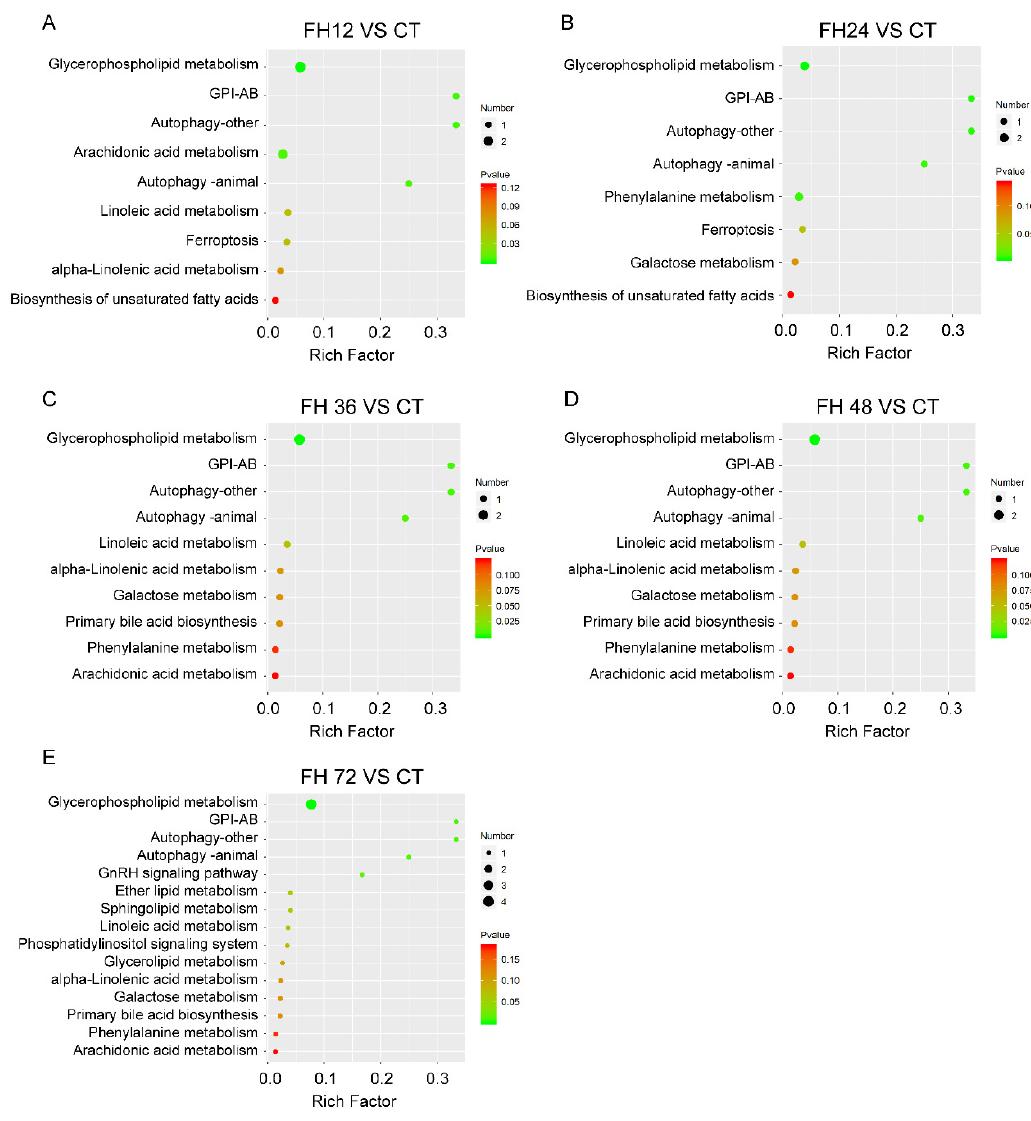
Figure 8. Changed pathways detected in the birds fasted for 12 h ( A ), 24 h ( B ), 36 h ( C ), 48 h ( D ), and 72 h ( E ) when compared with the birds fed ad libitum. CT—birds fed ad libitum; FH12—birds fasted for 12 h; FH24—birds fasted for 24 h; FH36—birds fasted for 36 h; FH48—birds fasted for 48 h.